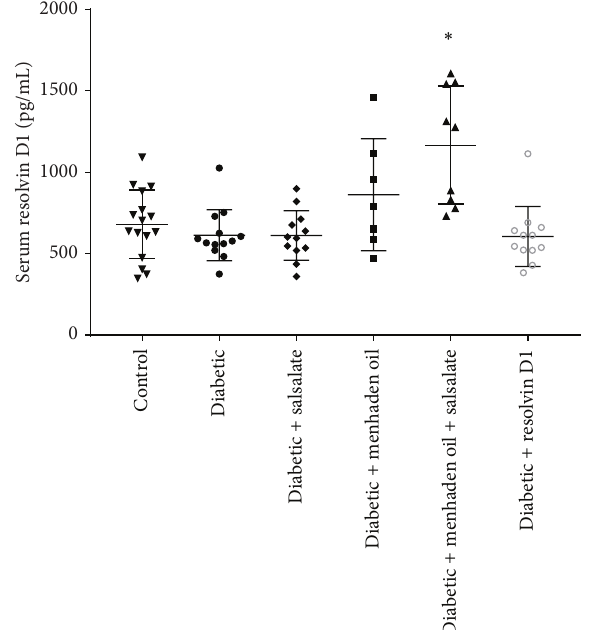
Figure 1: Scatter plot of serum resolvin D1 levels. Effects of 20 weeks of diabetes and 12 weeks of dietary treatment with salsalate, menhaden oil, menhaden oil plus salsalate, or resolvin D1 daily injections on serum levels of resolvin D1 in type 1 diabetic mice are presented. Serum levels are presented as mean ± SD and are in pg/mL serum. Each symbol per group represents a different animal. ∗ 𝑝 < 0.05 to control group.